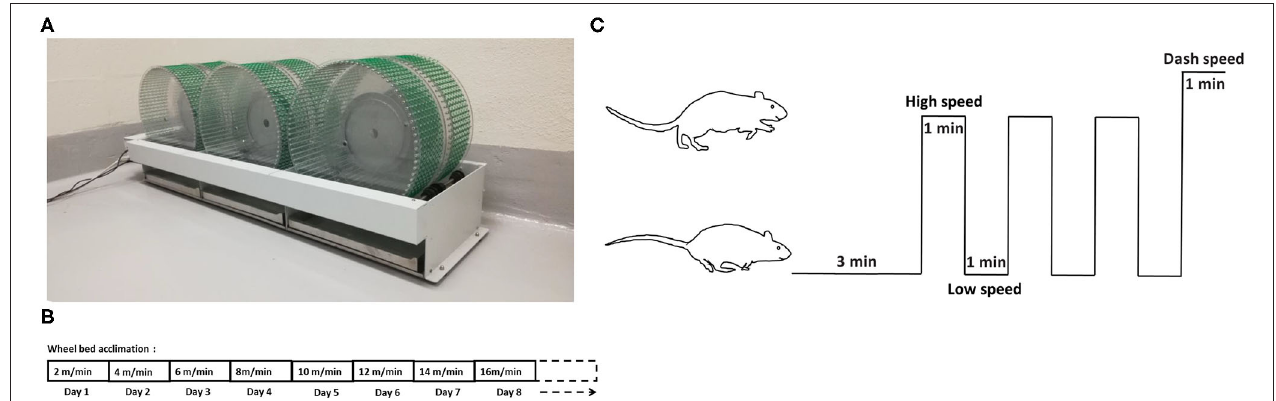
FIGURE 1 | Wheel-bed and the HIIT acclimation and training protocol. (A) Wheel-bed used on aged rats. (B) Acclimation protocol in aged rats. (C) The HIIT training diagram based on wheel-bed.